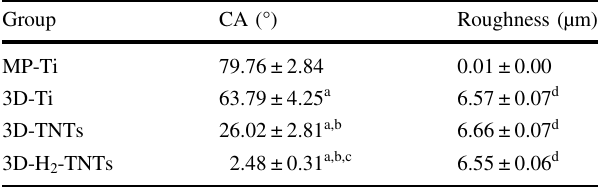
Table 1 Contact angle and surface roughness of the samples